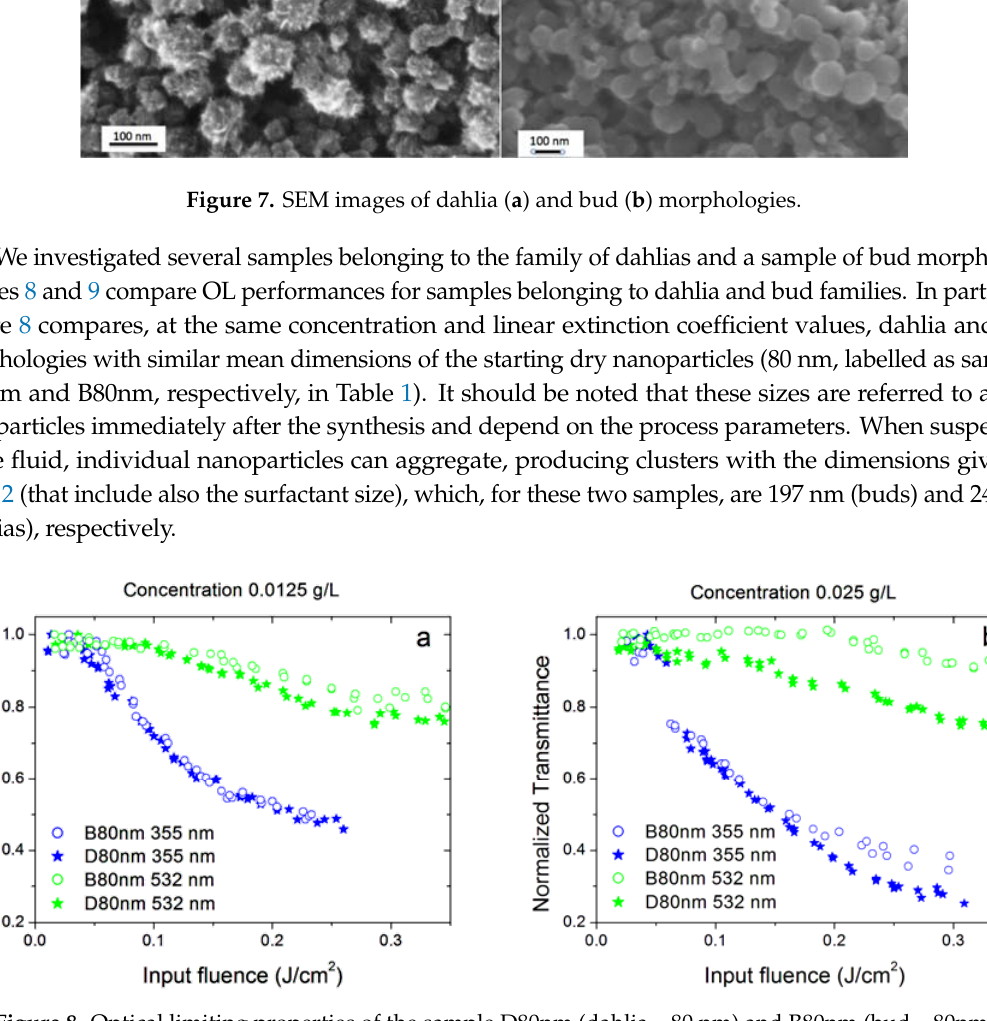
Figure 9. Optical limiting properties of the NH1 sample (dahlia) and B80nm (bud) at the 355 and 532 nm wavelengths: ( a ) for similar values of the linear extinction coefficient (corresponding to nanoparticle concentrations of 0.025 and 0.0125 g/L for dahlias and buds, respectively and ( b ) for the same nanoparticle concentration for both samples (0.025 g/L).